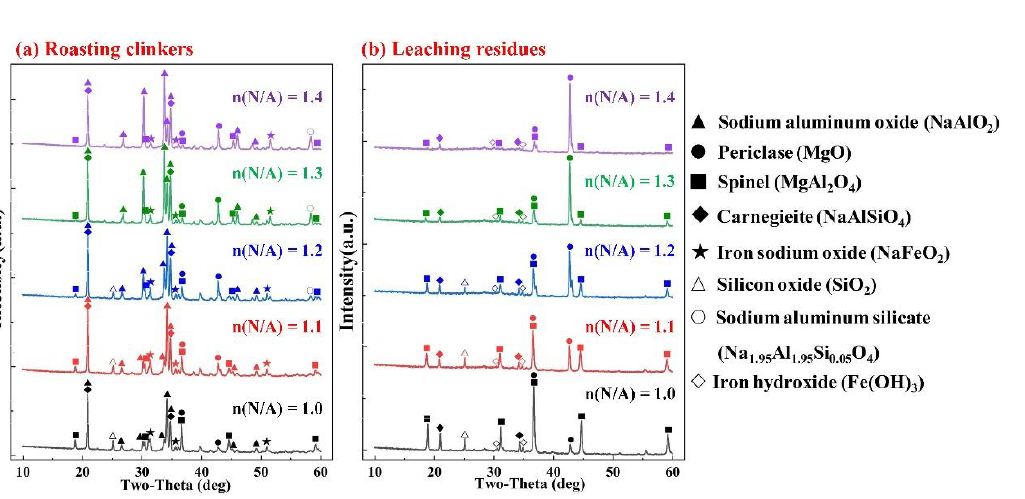
Figure 7. XRD patterns of the roasting clinkers ( a ) and leaching residues ( b ) under different Na 2 CO 3 /SAD mass ratios.